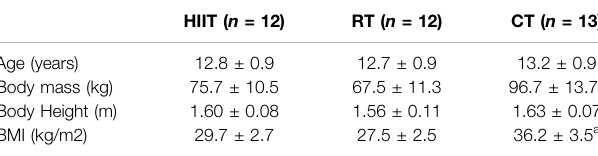
TABLE 1 | Baseline anthropometric characteristics of the study